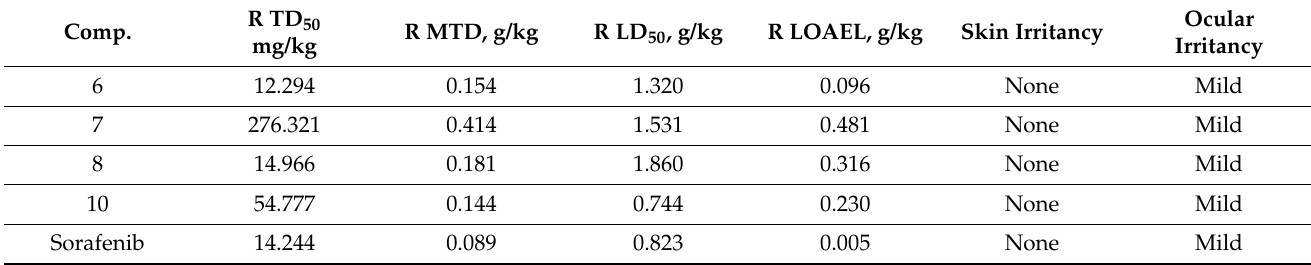
Table 7. Predicted toxicity parameters and properties of the synthesized